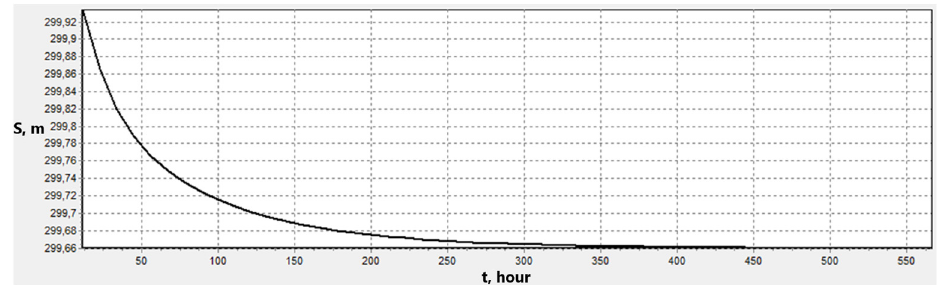
Figure 5. Graph of the fluid level lowering in the reservoir of the associated object, m.